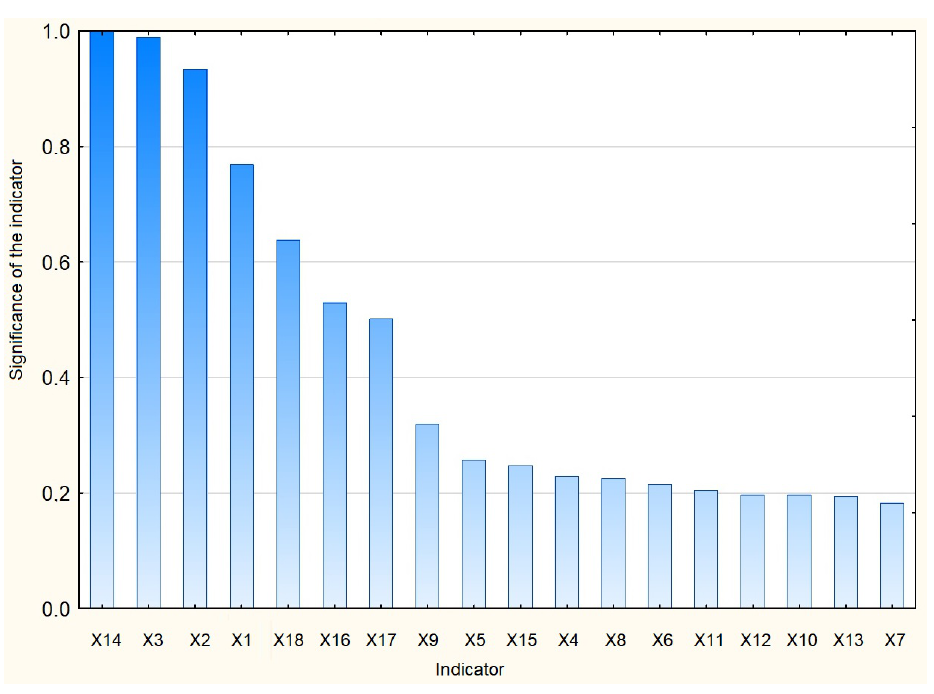
Figure 14. Histogram of the significance of